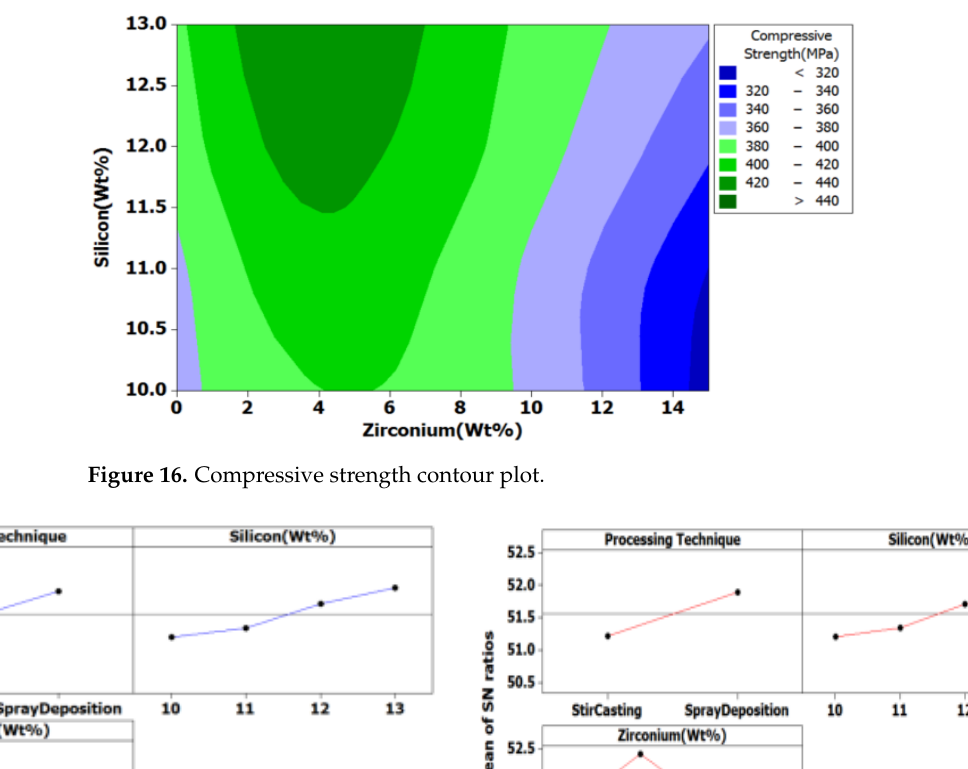
Figure 16. Compressive strength contour plot.